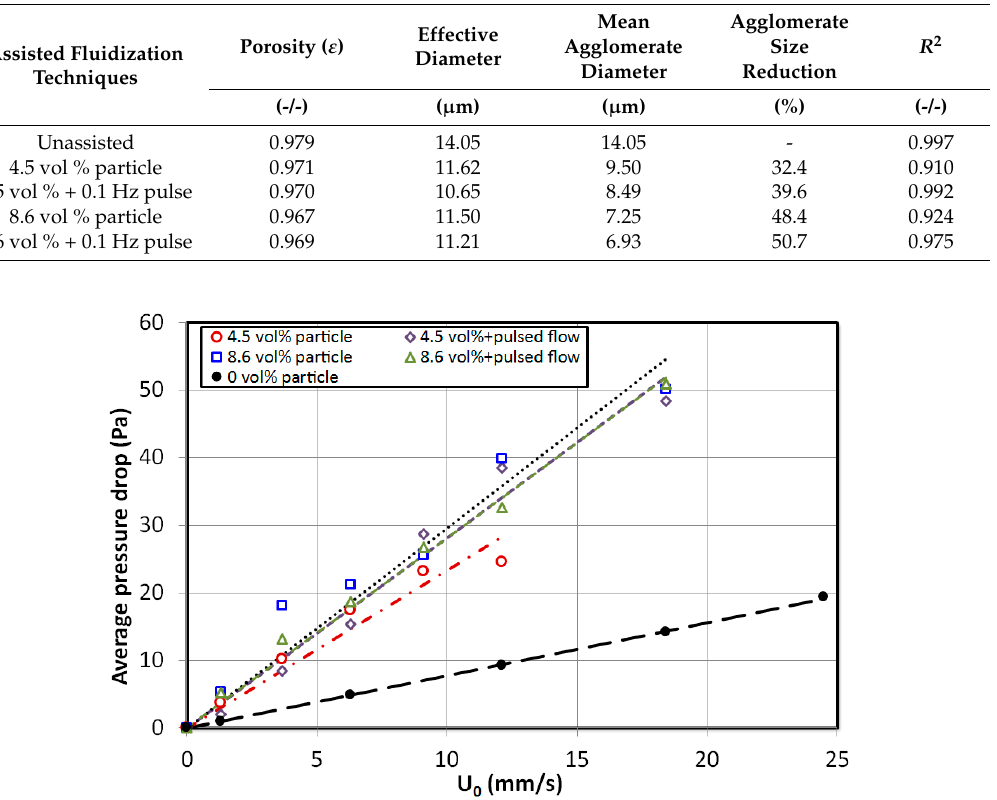
Table 2. Agglomerate size reduction under different fluidization conditions (external particle diameter: 56.5 µ m).